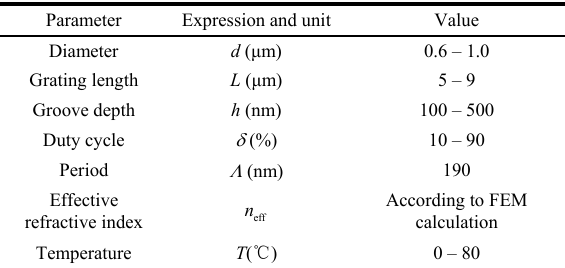
Table 1 Parameters used in the